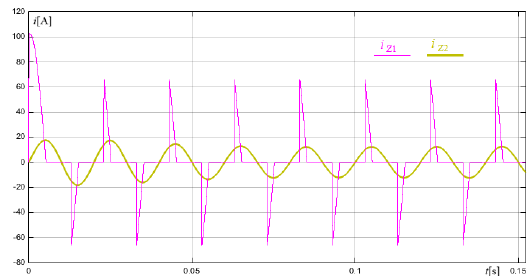
Fig. 5. Comparison of current ( i Z1 ) drawn by full bridge rectifier and current ( i Z2 ) drawn by full bridge rectifier with an input current modulator, set voltage is 300 VDC.